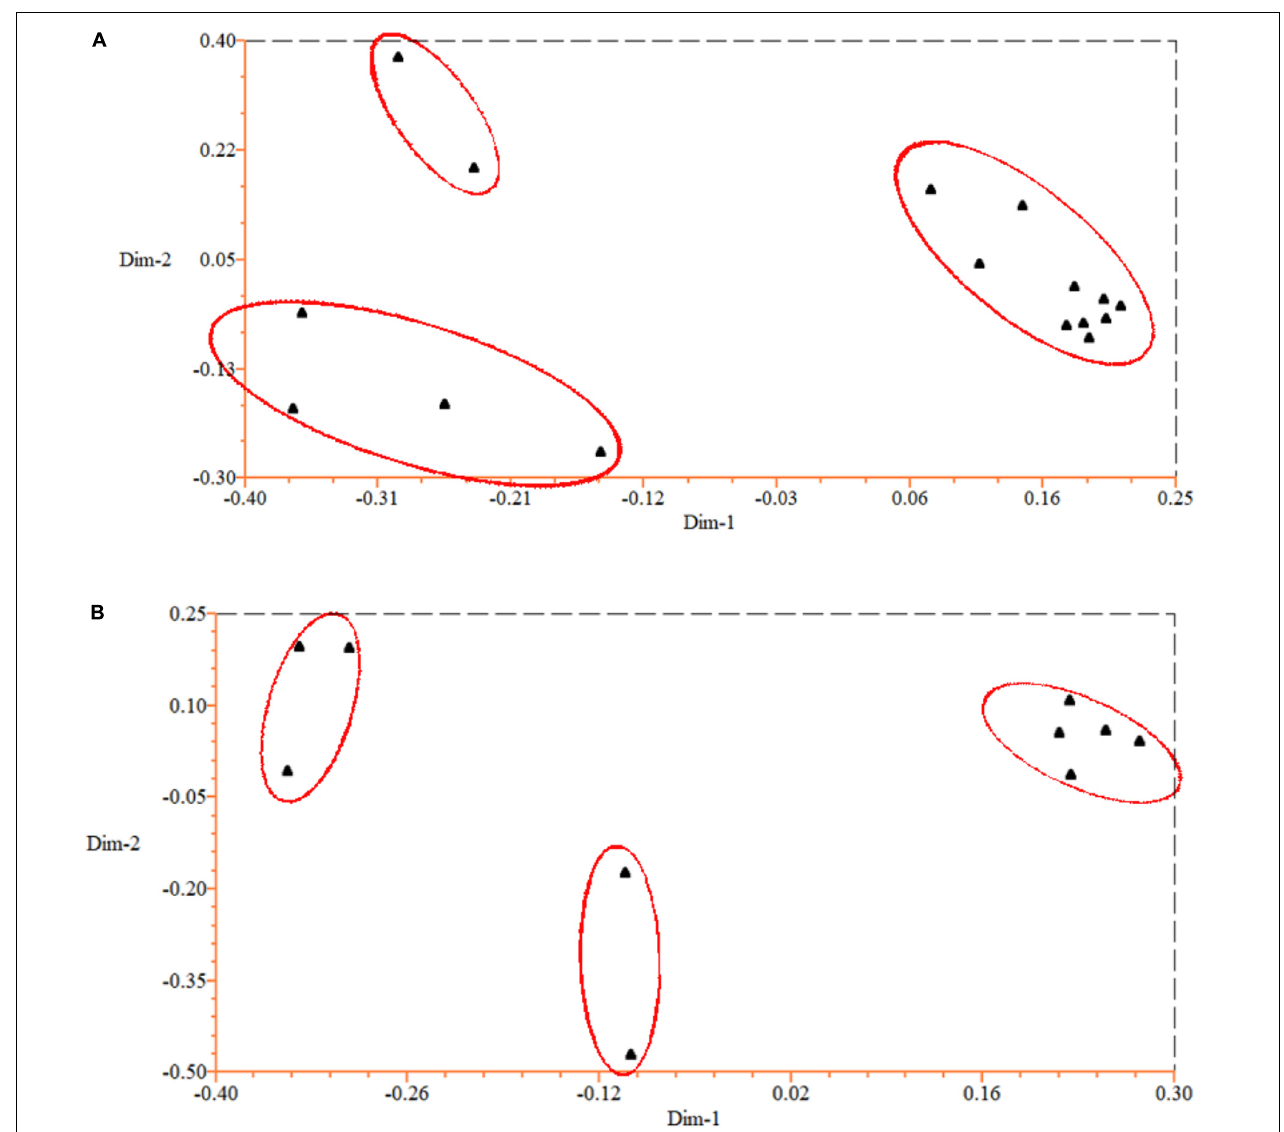
FIGURE 1 | Principal coordinates analysis (PCoA) of Phyllostachys violascens based on EST-SSR data for (A) 16 P. violascens varieties and (B) 10 Phyllostachys species.